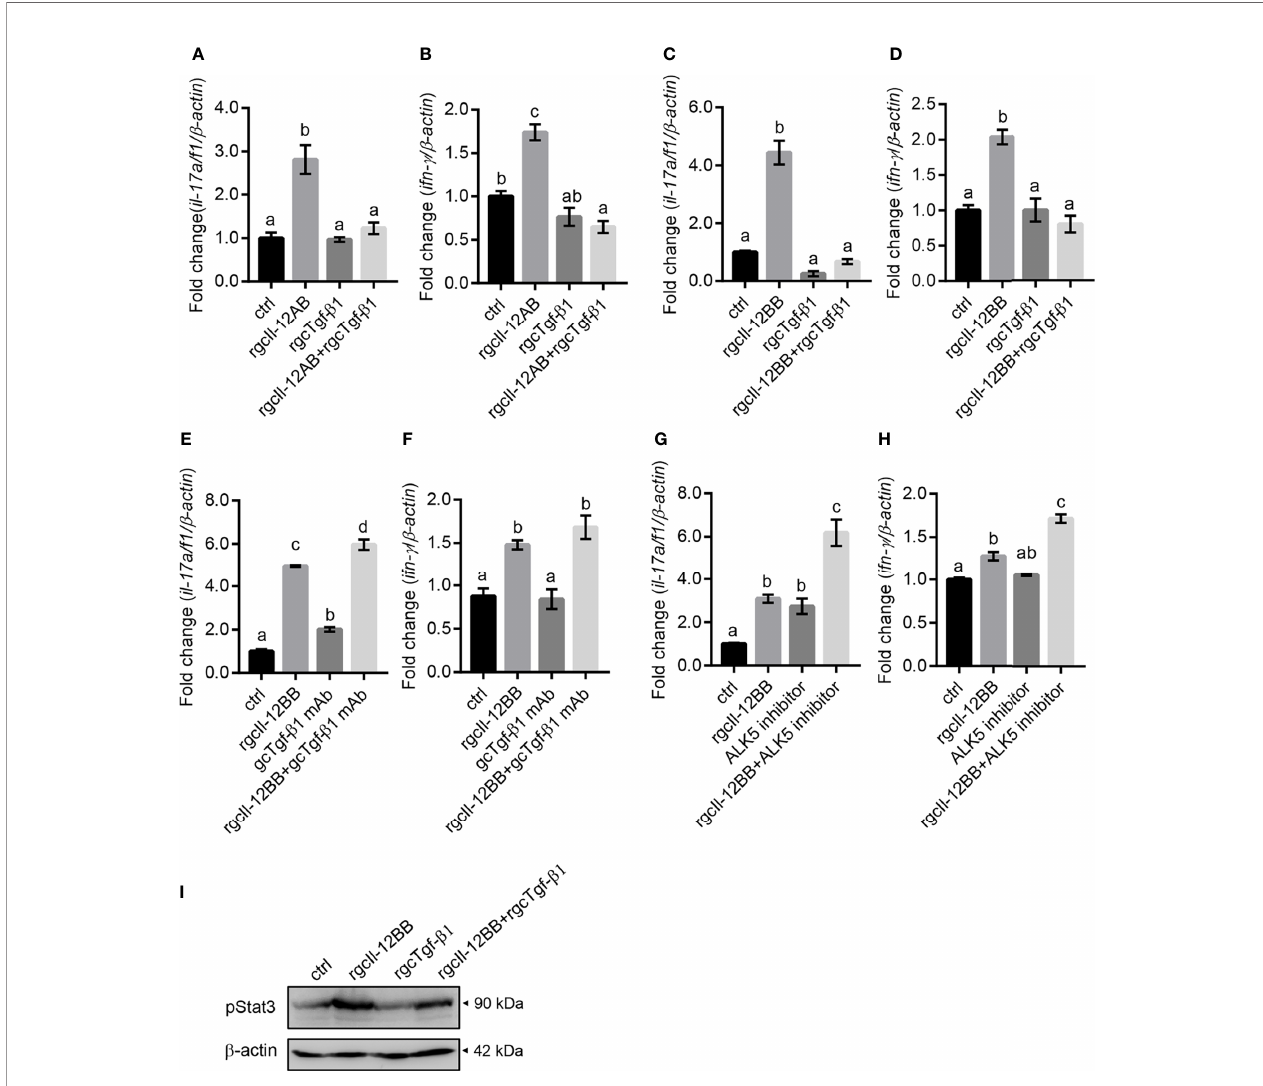
FIGURE 9 | The effects of gcTgf- b 1 on rgcIl-12AB- and rgcIl-12BB-induced il-17a/f1 and ifn- g mRNA expression. Lymphocytes were treated with 1000 ng/mL of rgcIl-12AB (A, B) and rgcIl-12BB (C, D) in the presence or absence of rgcTgf- b 1 (100 ng/mL) for 12 h. (E, F) Lymphocytes were exposed to rgcIl-12BB (1000 ng/mL) in the presence or absence of gcTgf- b 1 mAb (1:1000 diluted) for 12 h. (G, H) Lymphocytes were incubated with rgcIl-12BB (1000 ng/mL) in the presence or absence of ALK5 inhibitor (TGF- b 1 RI Kinase inhibitor VIII, 2 µM) for 12 h. Then the levels of il-17a/f1 and ifn- g mRNA were detected by qPCR. Relative mRNA levels were analyzed using b -actin as an internal reference and expressed as the fold changes of the control group (blank column). Data are shown as mean ± SEM (N = 4). Different letters indicate signi fi cant differences at p < 0.05. (I) Phosphorylation of Stat3 was detected in lymphocytes incubated with rgcIl-12BB (1000 ng/mL) in the presence or absence of rgcTgf- b 1 (100 ng/mL) for 20